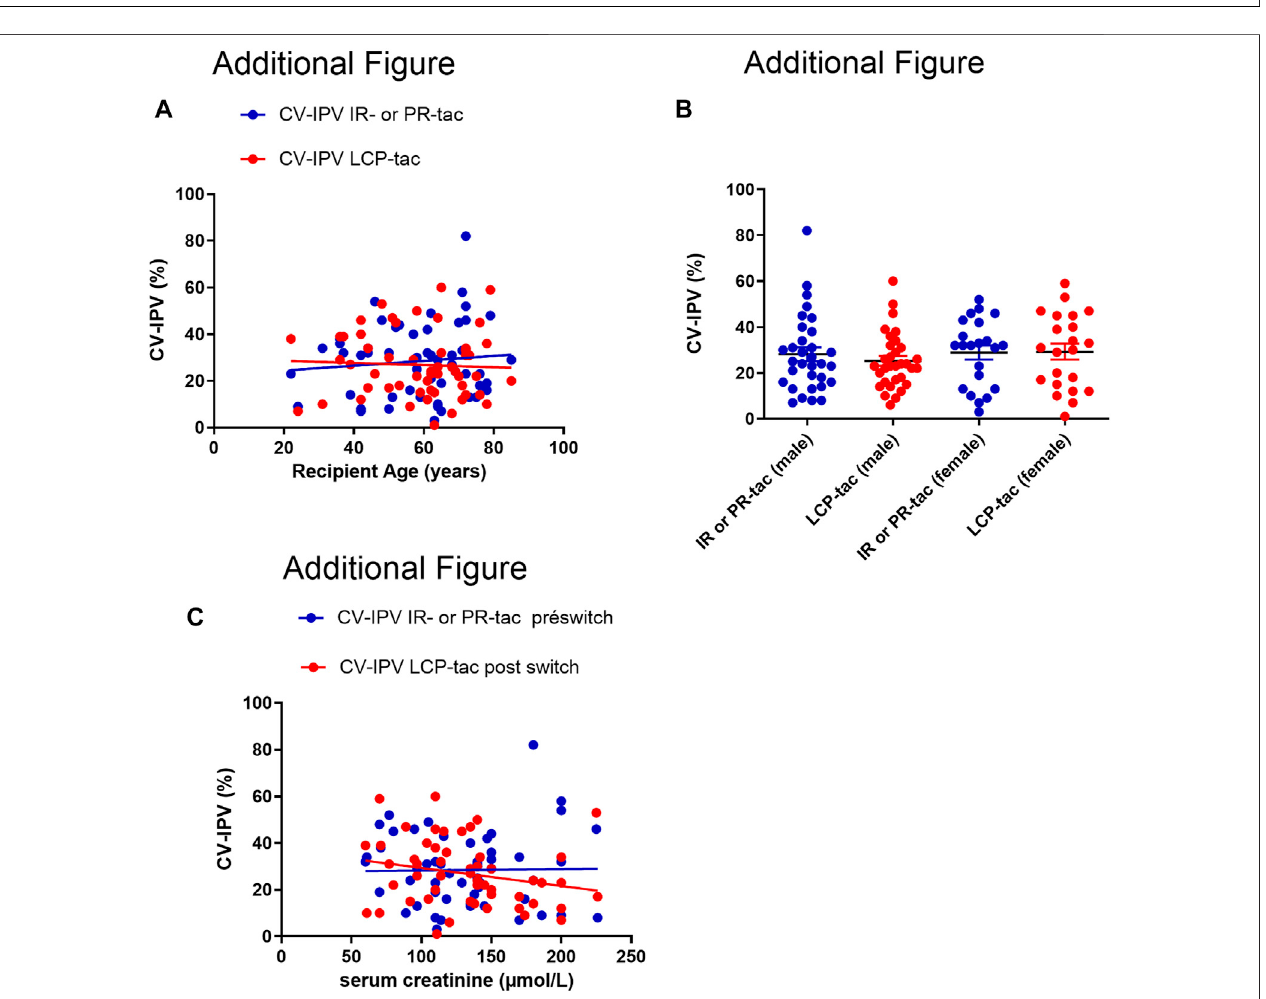
Frontiers in Pharmacology |